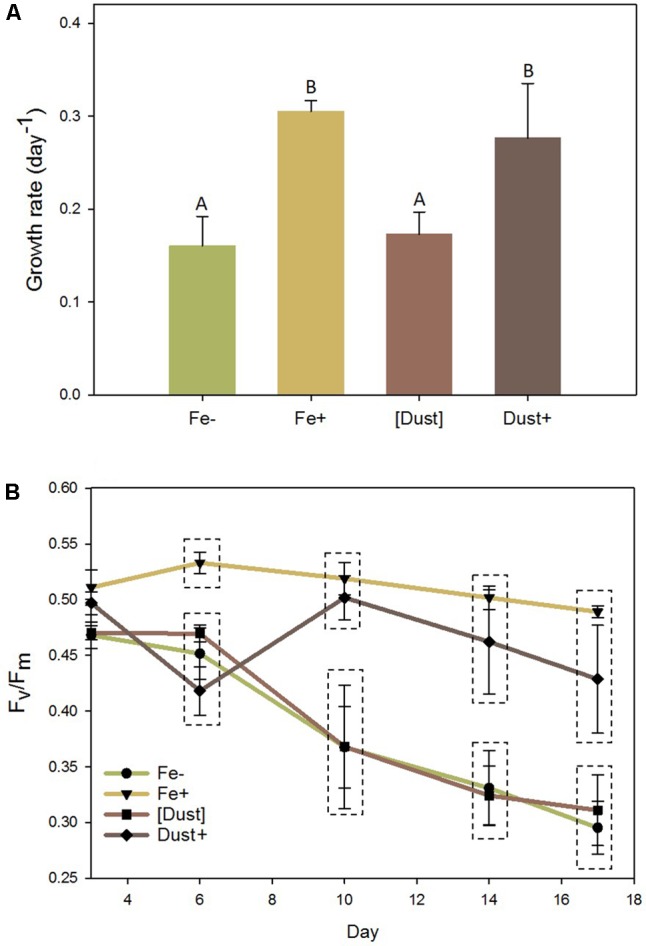
Effects of desert dust and Fe’ on Trichodesmium physiology. Dust added (Dust+, dark brown), dust separated ([Dust], light brown), Fe’ replete (Fe+, yellow) and Fe’ deficient (Fe–, green) Trichodesmium cultures were monitored over 17 days during which (A) growth rates (day-1) and (B) photosynthetic efficiency (Fv/Fm) were recorded. Statistically significant differences (GLM and Tukey test; P < 0.05) between treatments are indicated with dissimilar letter groups (A) or dashed boxes (B). Error bars represent standard deviations of three biological replicates. (GLM and Tukey test, P < 0.05).